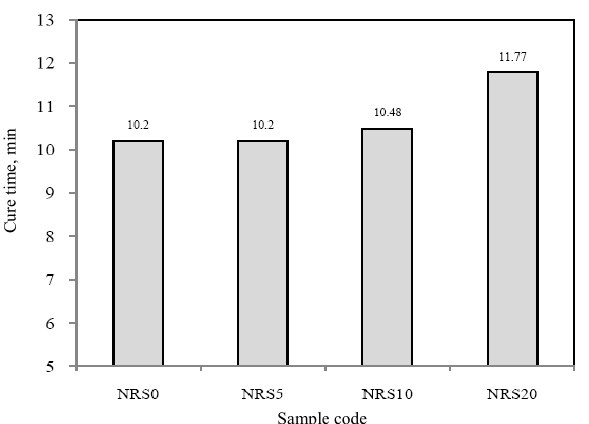
Figure 2. Cure time of samples at various silica ratios.